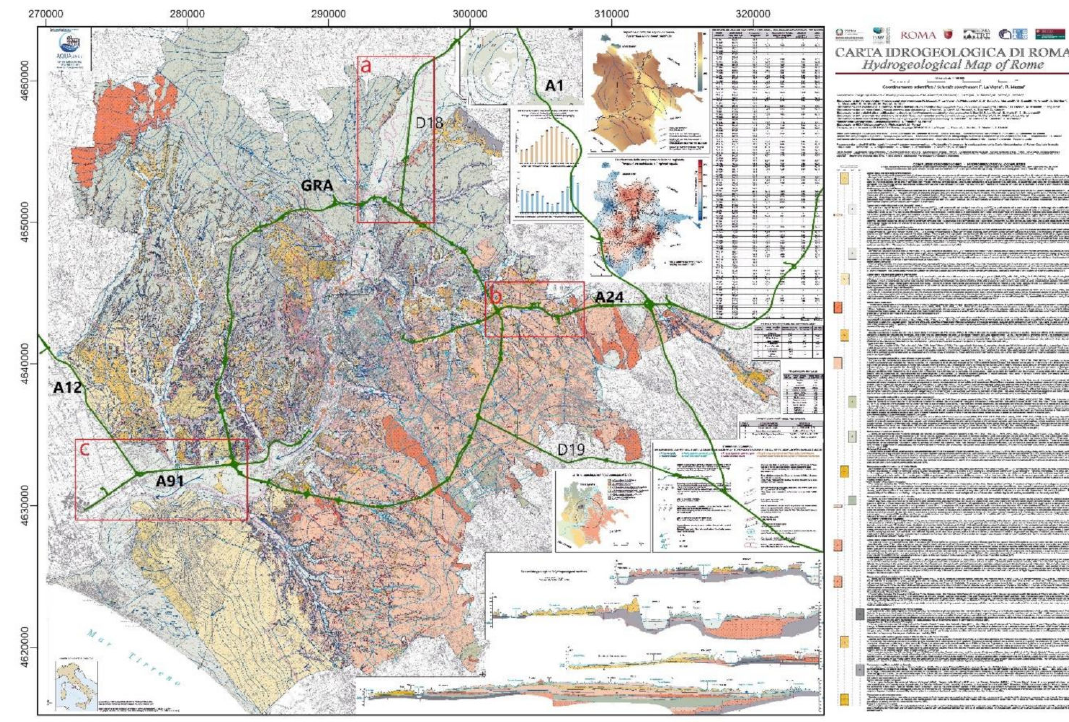
Figure 1. Highway network route of Metropolitan Rome, as a background Hydrogeological map of Rome (La Vigna et al.,